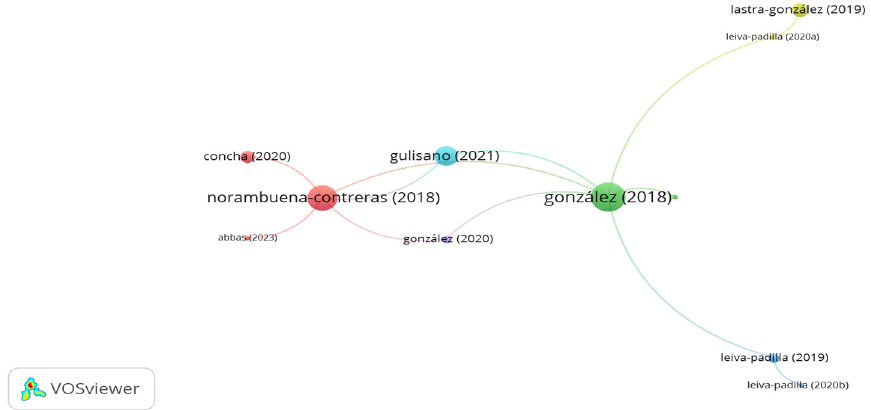
Figure 22. Network visualization of metallic fibers.